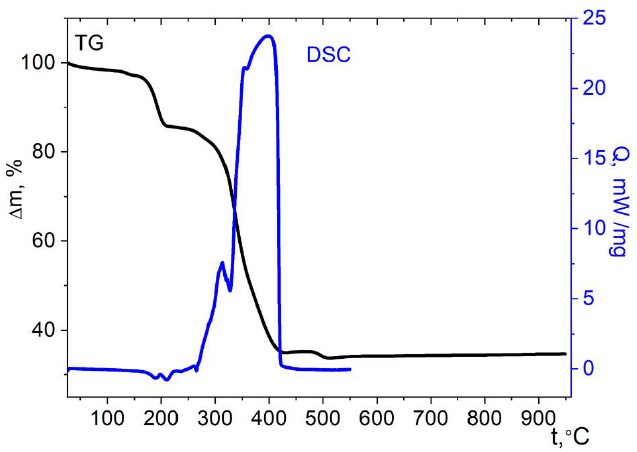
Figure 11. Thermolysis of complex 3 under